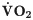
Correlations of the increases in V˙O2 with respiratory rate (A), tidal volume (B), minute ventilation (C), heart rate (D), stroke volume (E), cardiac output (F), and arterial-venous oxygen difference (G) from first threshold to peak exercise.